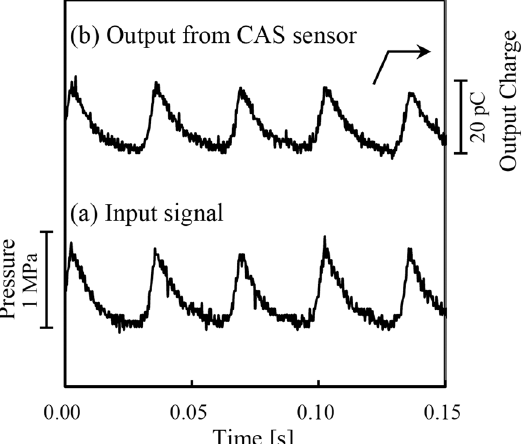
Figure 20. Output from CAS high-temperature pressure sensor at 700 °C [97] (copyright 2013 by the American Institute of